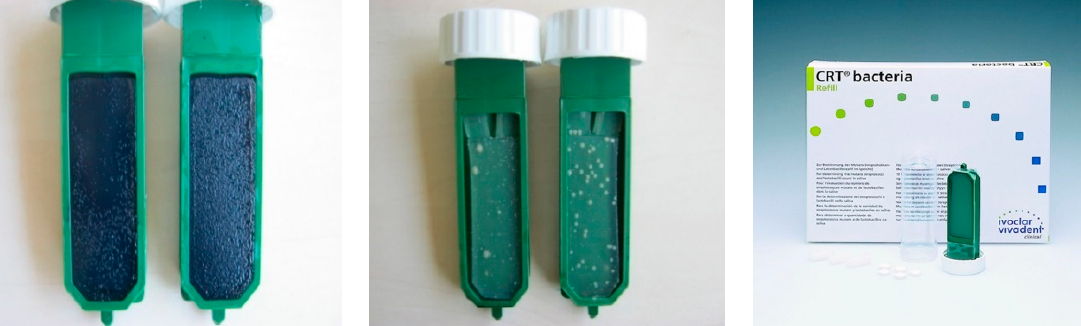
Figure 1. Colonies forming units (CFU) of Mutans Streptococci (MS) ( left ) and Lactobacillus (LB) ( middle ) and Caries Risk Test CRT ( right ).